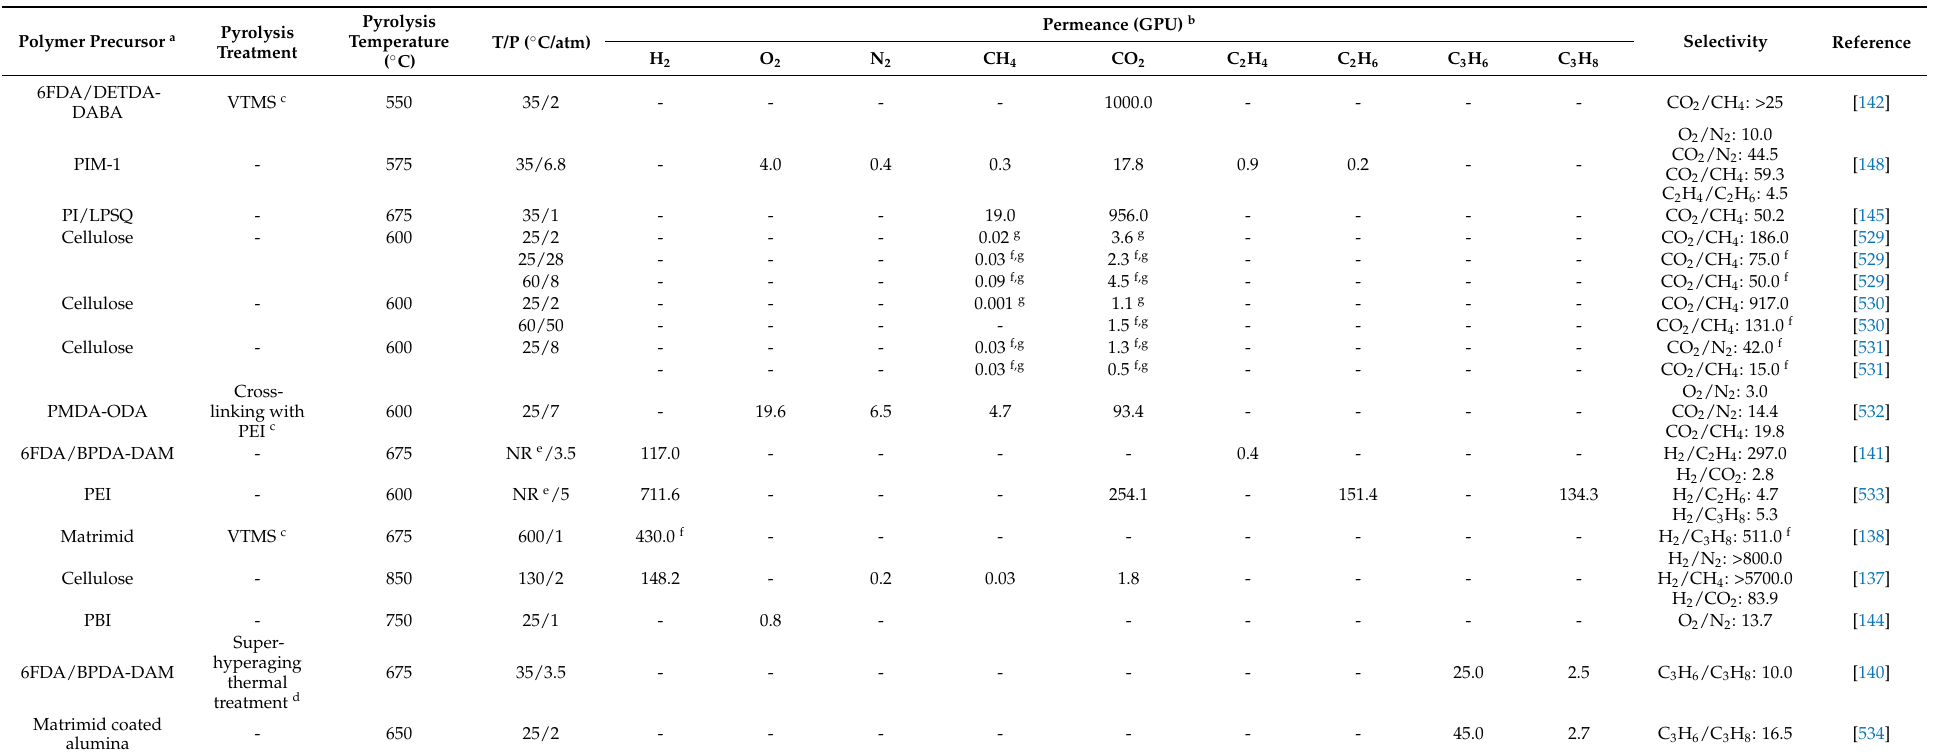
Table 4. Recent state-of-the-art CMS hollow fiber membranes for CO 2 capture, air purification, H 2 /alkane separation, and olefin/paraffin